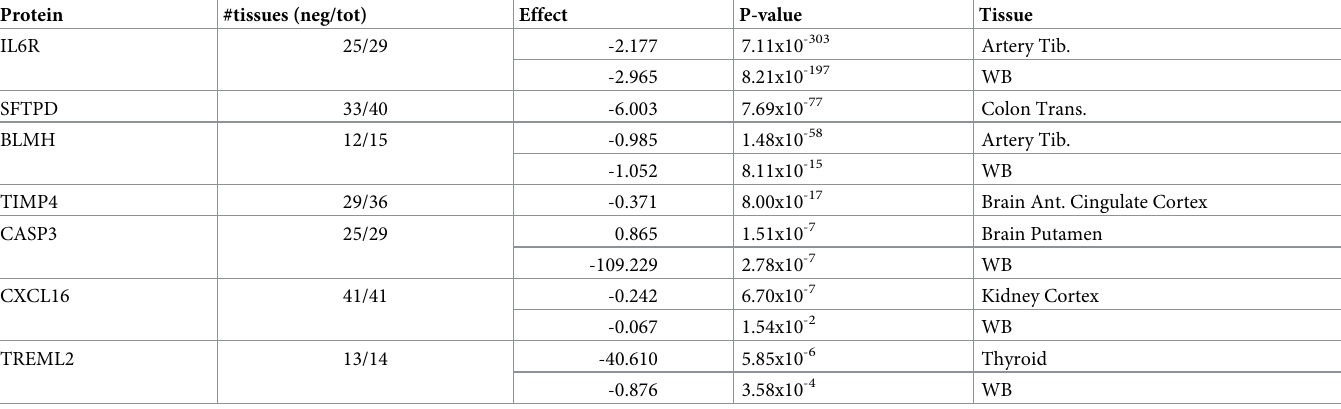
MetaXcan results are shown for the best-associated tissue with negative effect estimate and whole blood (WB), if a prediction model was available. Neg = Number of significant negative correlations across tissues. Tot = Total number of significant